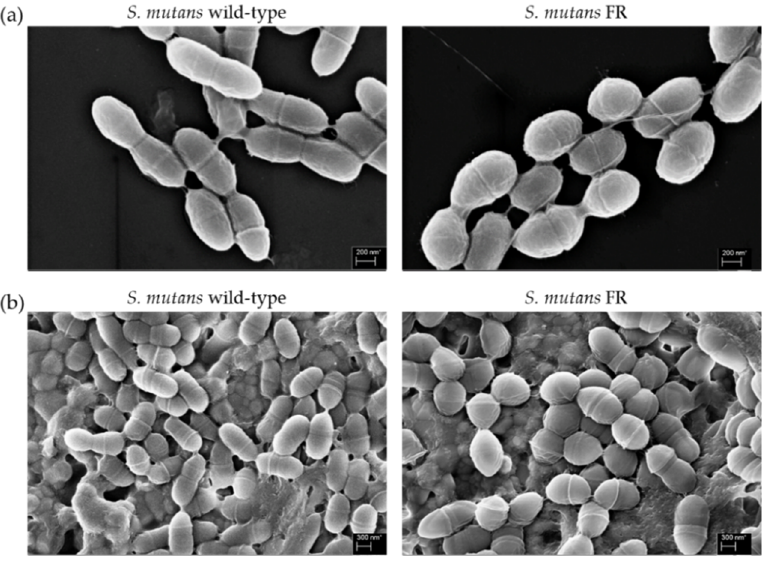
Figure 3. Cell morphology. The wild-type and FR S. mutans strains were grown to late-exponential phase (OD 600 = 0.6–0.7) in BHI medium at 37 °C in a 5% CO 2 atmosphere. The cultures were fixed on either ( a ) a glass slide or ( b ) HA disc and observed at 30,000× magnification using a SUPRA25